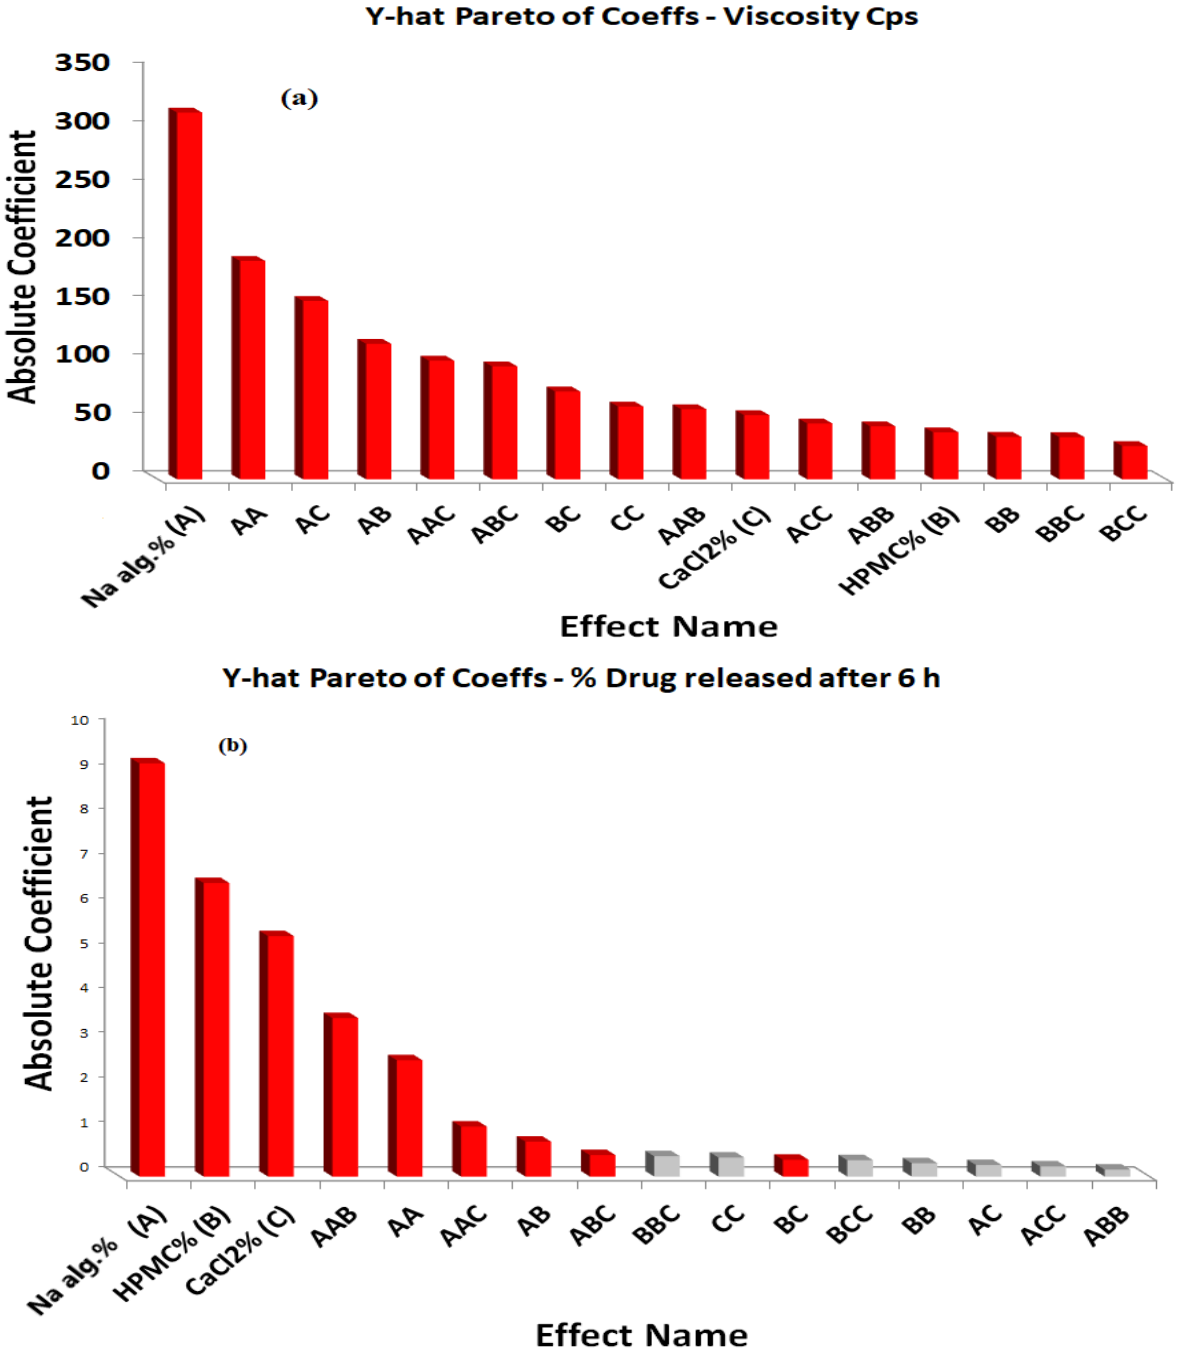
Figure 3. Y-hat Pareto chart showing ( a ) the standardized effect of independent variables and their interaction on the viscosity of the in situ forming gels, ( b ) the standardized effect of independent variables and their interaction on the percentage of drug released after 6 h from the in situ forming gels; (red color indicates significant effect; grey color indicates insignificant effect). The percentage of the drug released after 6 h was found to be in the range of 35.24 to 68.59%. A polynomial equation was also developed for the percentage of the drug re- leased after 6 h: